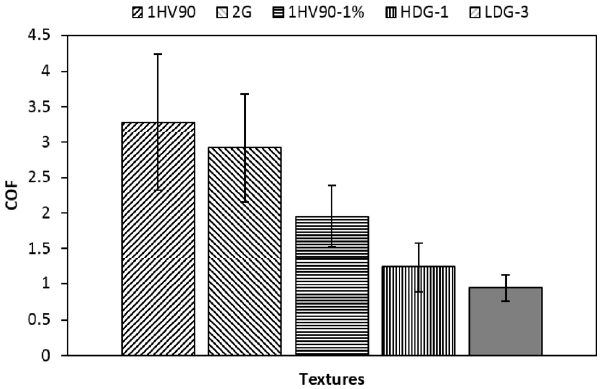
Fig. 6 The average values of COF of the kinetic friction measurements (five sliding cycles) for the 5 samples, sorted in decreasing